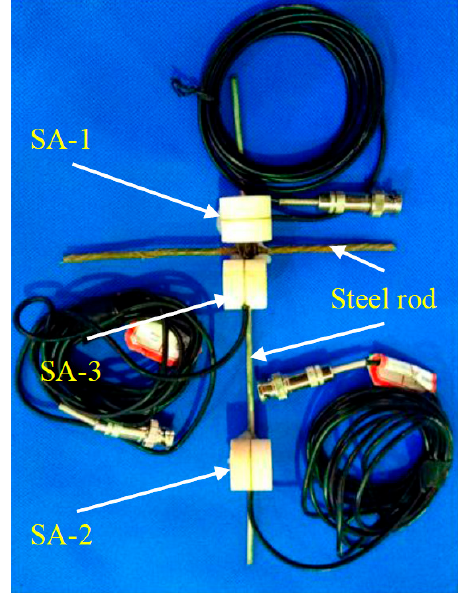
Figure 9. The smart aggregates prior to embedment.